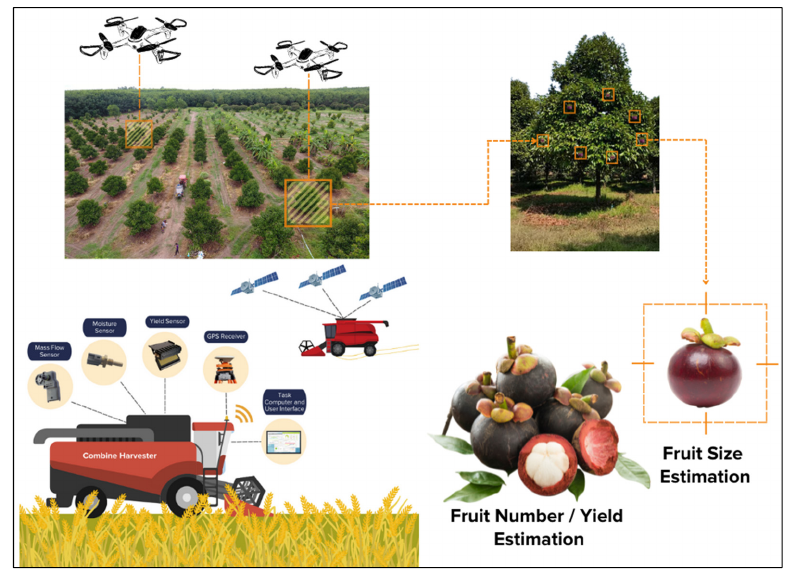
Figure 4. Sensors- and drones-assisted quality monitoring of horticultural crops and yield prediction during harvesting of crops.